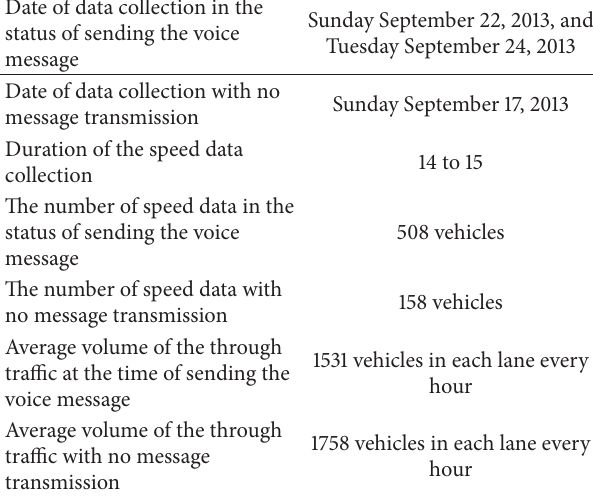
Table 1: Passing vehicles speed